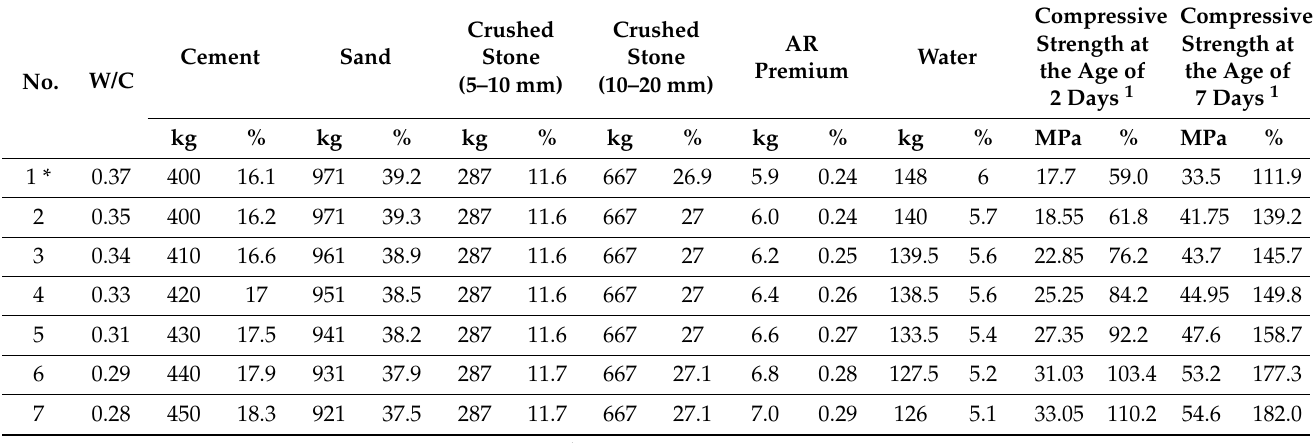
Table 15. RHC compositions per 1 m 3 with the increased amount of cement and AR Premium.